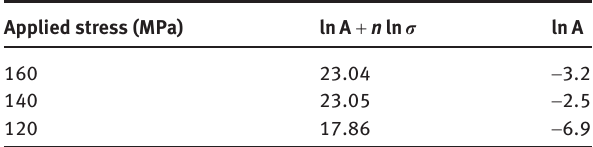
Table 2: The calculated values of constant A. Applied stress (MPa)